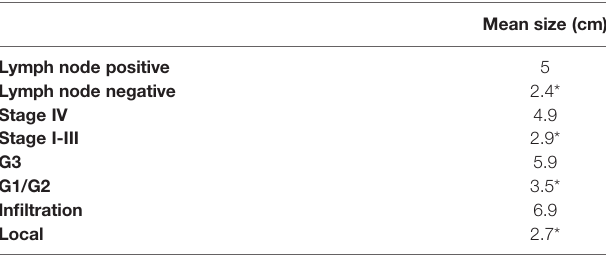
TABLE 4 | The signi fi cance of mean tumor size on tumor grade and stage in pancreatic neuroendocrine tumors.